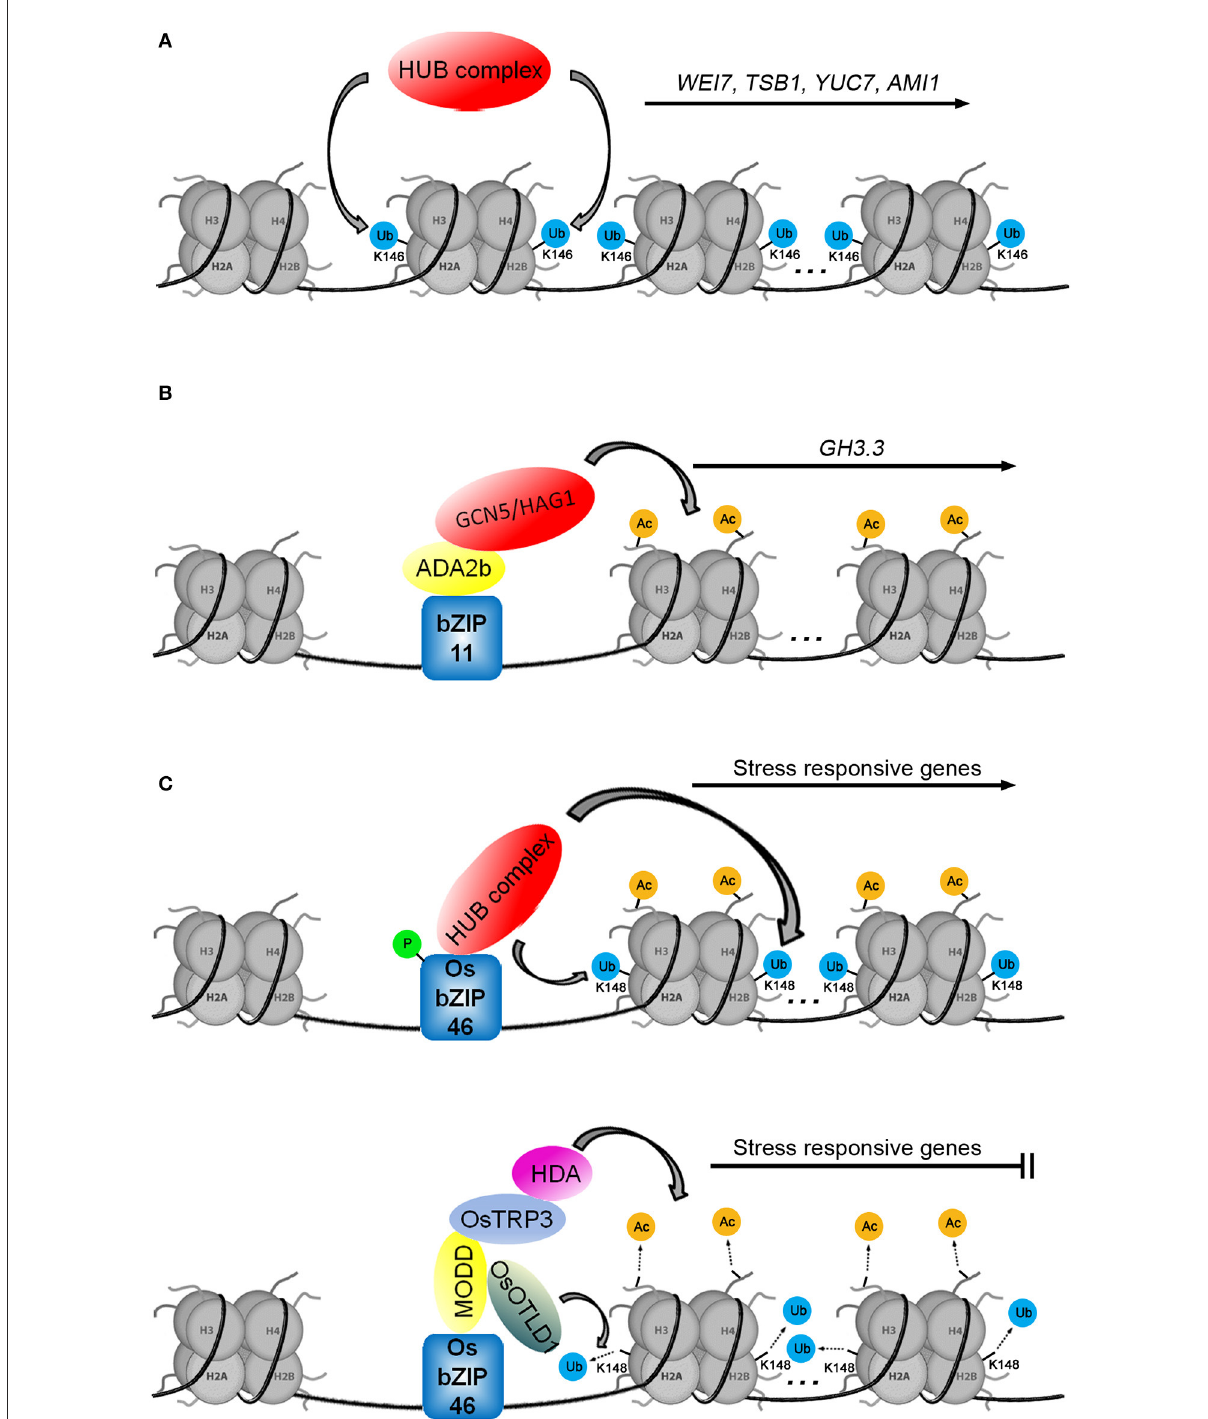
FIGURE4 Three models for histone ubiquitination and/or acetylation are involved in transcriptional regulation. (A) The auxin biosynthetic genes WEI7 , TSB1 , YUC7, and AMI1 are regulated by H2Bub1. (B) The transcription factor bZIP11 positively regulates GH3.3 by recruiting the ADA2b-GCN5/HAG1 complex. (C) H2Bub1 (according to the study of Cao et al., 2008, we speculate that the monoubiquitination modification of H2B occurs at the K148 of H2B in Oryza sativa L.) and H3ac are involved in the regulation of stress-responsive genes (in Tang et al., 2016, the sites of histone lysine residues modified by acetylation were not